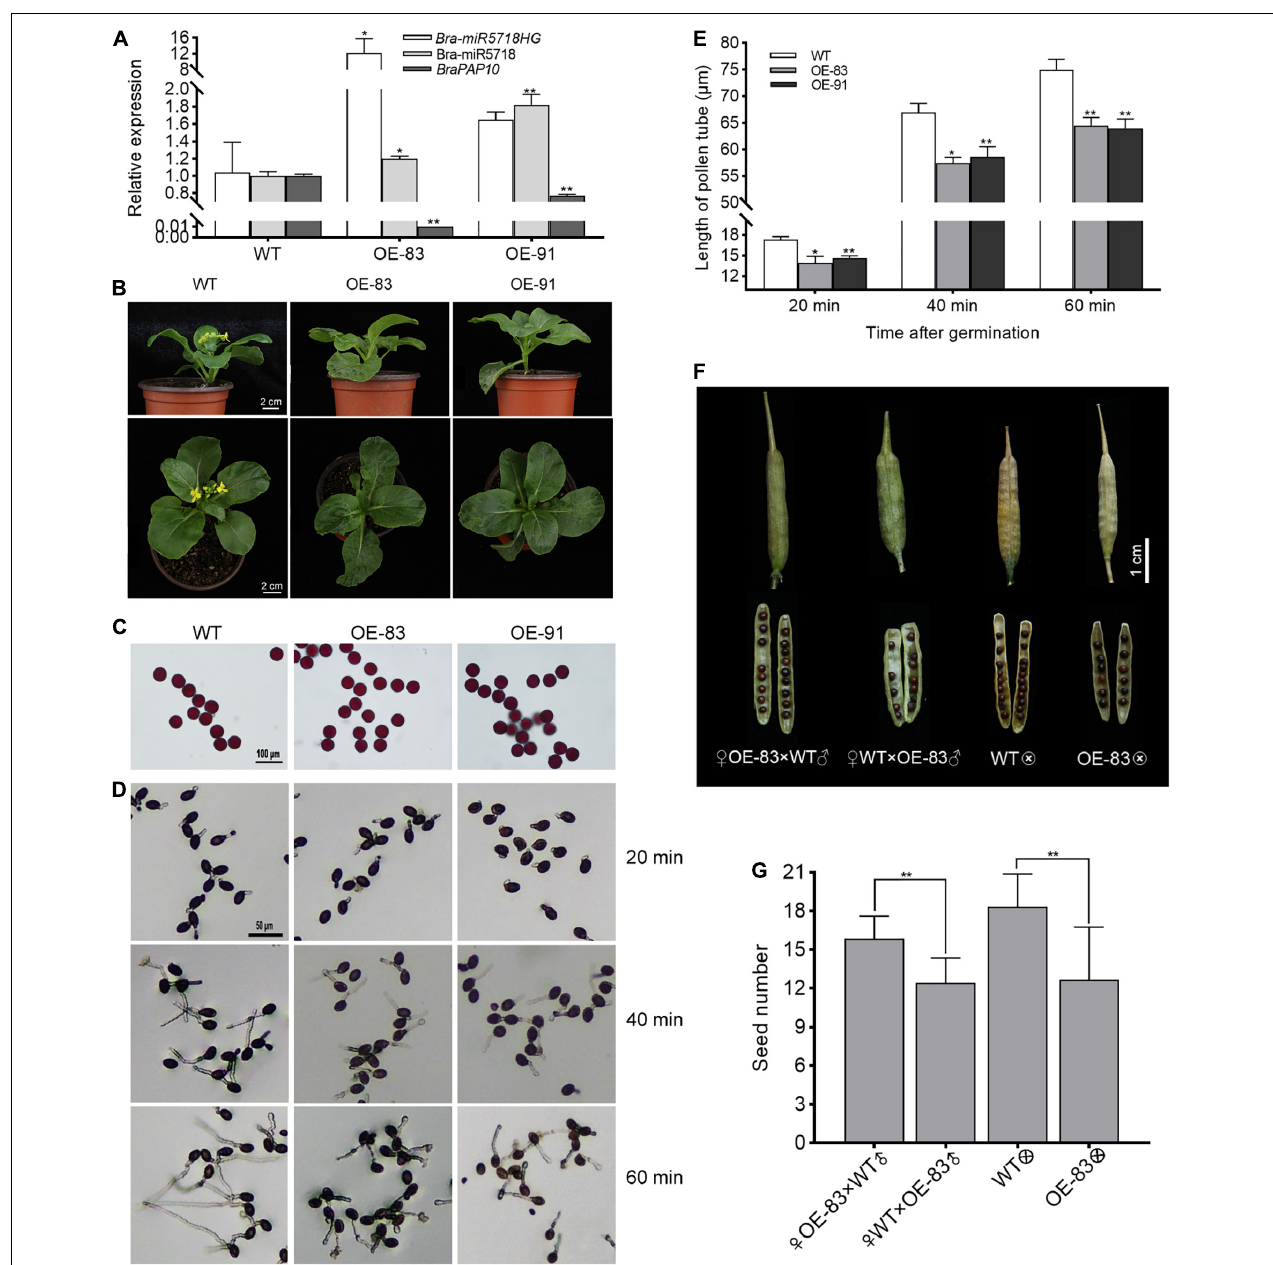
FIGURE 7 | Bra-miR5718HG slow down pollen tube growth via working as host genes for miR5718 in B. campestris . (A) Relative expression of bra-miR5718HG , bra-miR5718, and braPAP10 in transgenic and wild-type (WT) plants. (B) Photograph of bra-miR5718HG overexpression transgenic lines and WT. (C) Alexander staining of pollen grains from bra-miR5718HG overexpressing plants in B. camperstris . (D) Representative photograph of pollen germination in vitro of overexpression lines and WT. (E) Pollen tubes length of overexpression lines and WT at different times after germination. (F) Representative photograph of siliques from reciprocal cross and self-cross of transgenic and WT plants. (G) statistics of seed number of siliques from reciprocal cross and self-cross of transgenic and WT plants. Data were presented as mean ± SD and the t -test was used for significance analysis. ** P < 0.01. Triplicate experiments were conducted.